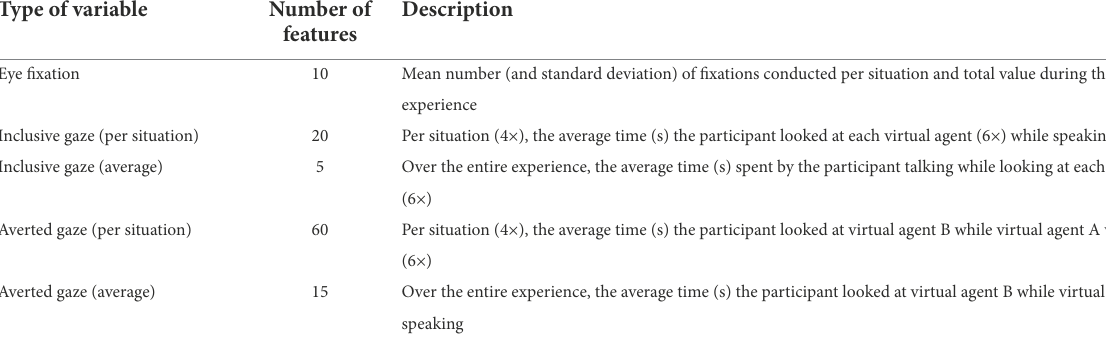
TABLE 3 Description of the eye-tracking variables.